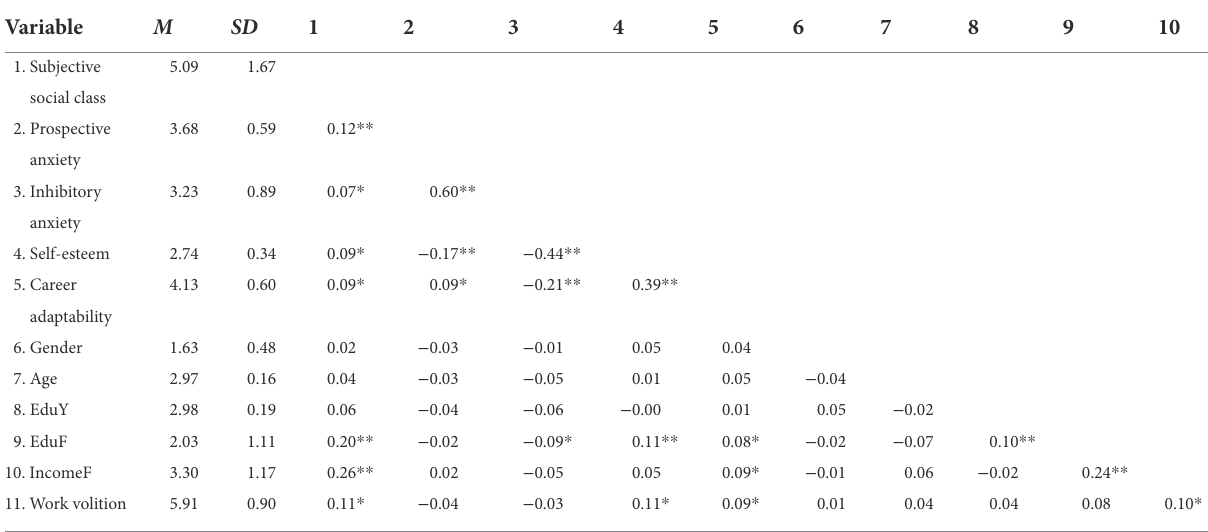
TABLE 1 Descriptive statistics and correlations.